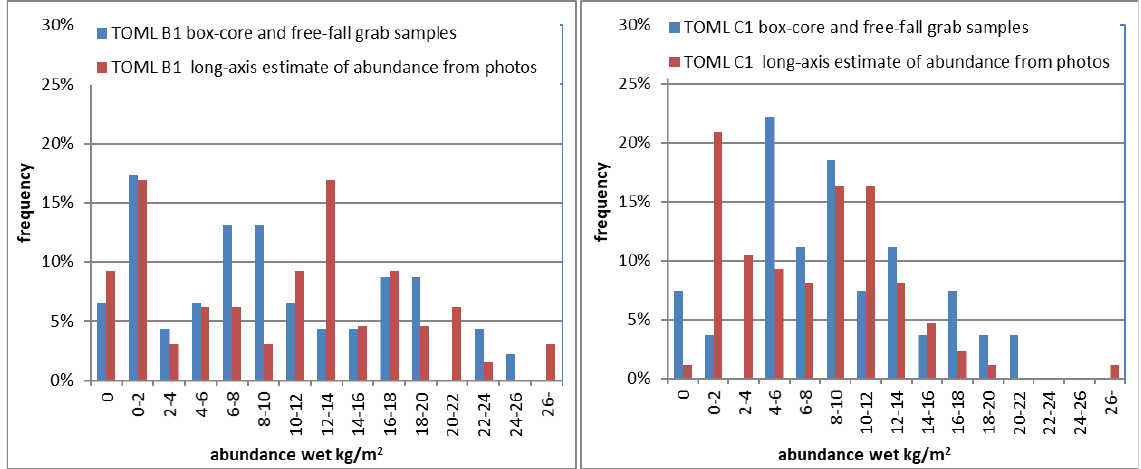
Figure 20. Histograms of abundances measured by physical sampling and the photograph-based long-axis estimate across TOML areas B1 and C1.